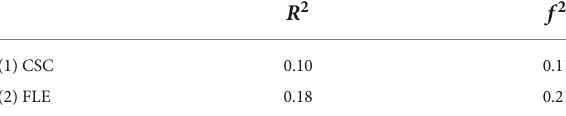
TABLE 4 Standardized parameter estimates for the structural